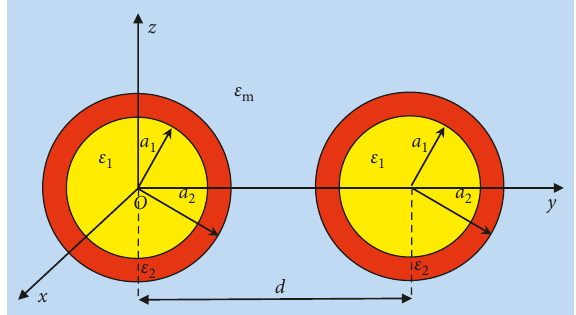
Figure 1: System of two